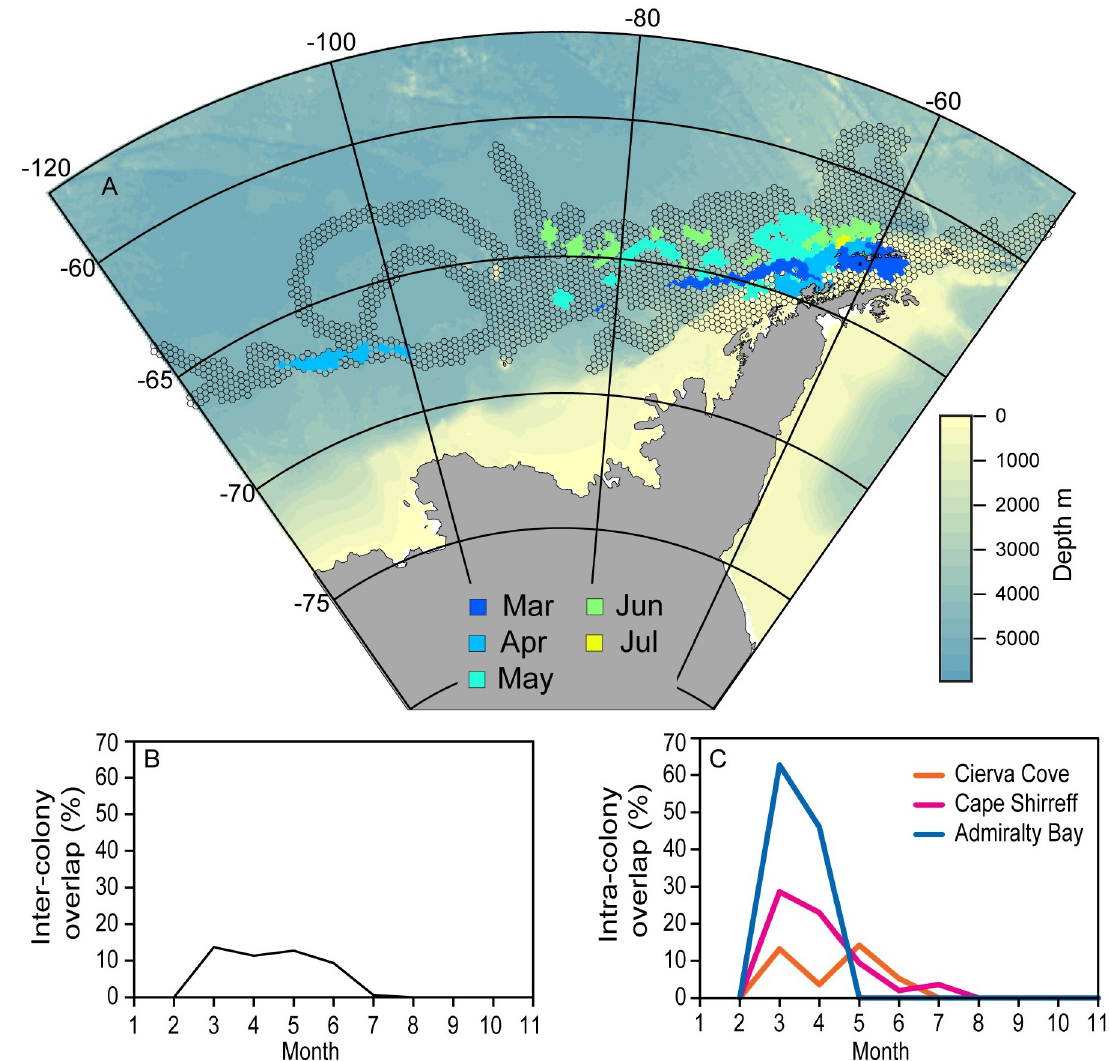
Fig 6. Map and indices of overlap. A) Areas of monthly inter-colony overlap from the three tagging locations. For reference, the background HUD (gray) is combined across all months and tagging locations. B) Monthly inter-colony overlap as a percentage of the total area occupied each month by birds from all colonies. C) Monthly intra-colony overlap as a percentage of the total area occupied each month by birds from a given